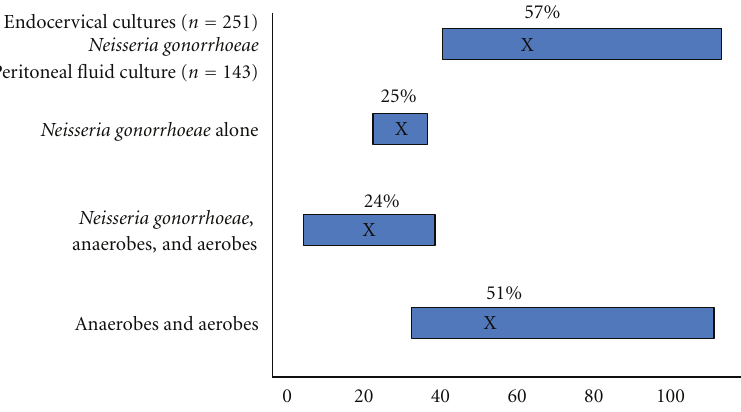
Figure 1: Microbiologic Etiology of Acute PID as determined by Culdocentesis, (based on references